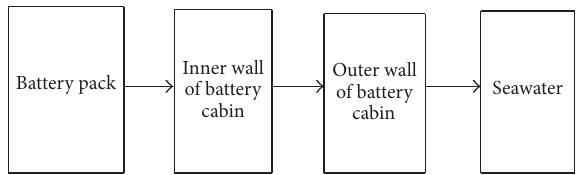
Figure 1: Schematic diagram of heat dissipation and conduction of battery